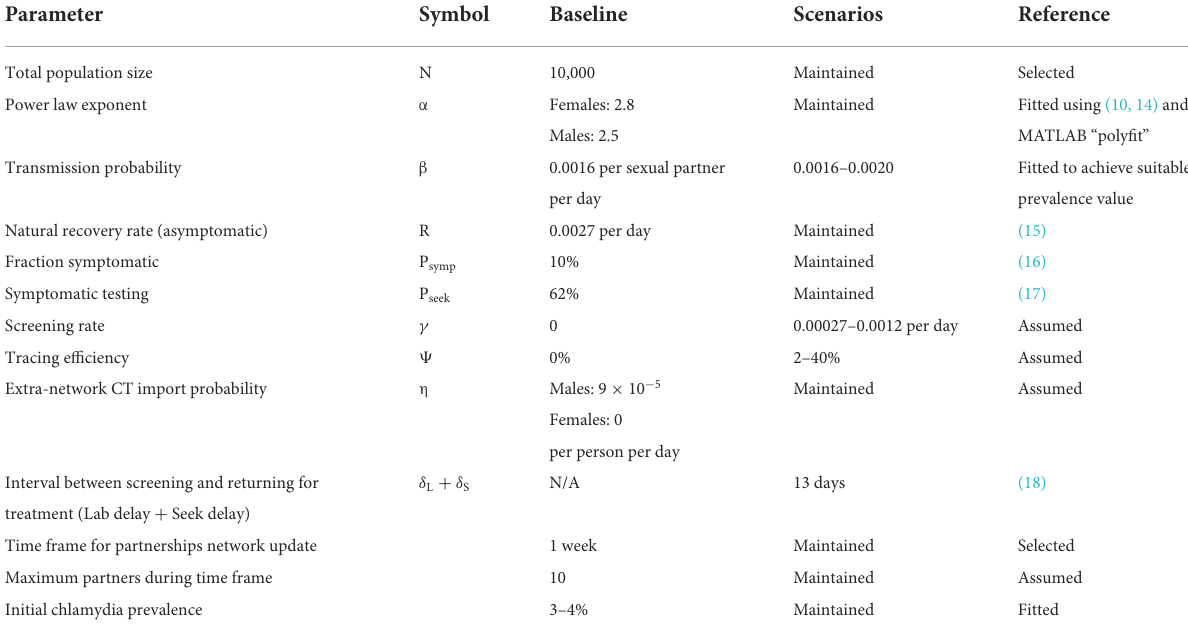
TABLE 1 Parameter values, and reference, used in the model scenarios presented in this